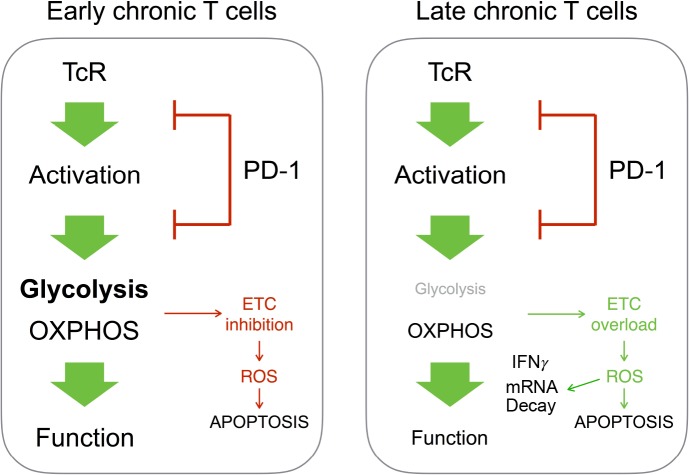
Different outcome from PD-1-mediated regulation of T cell metabolism in early or late chronic antigen stimulation.In chronic T cells responsible for early GVHD, PD-1-mediated inhibition of T cell metabolism promotes mitochondrial dysfunction and cell death. In T cells responsible for late GVHD, failure to engage glycolysis after PD-1 blockade stimulates OXPHOS. This leads to overload of the electron transport chain (ETC), ROS production, mRNA decay and cell death.